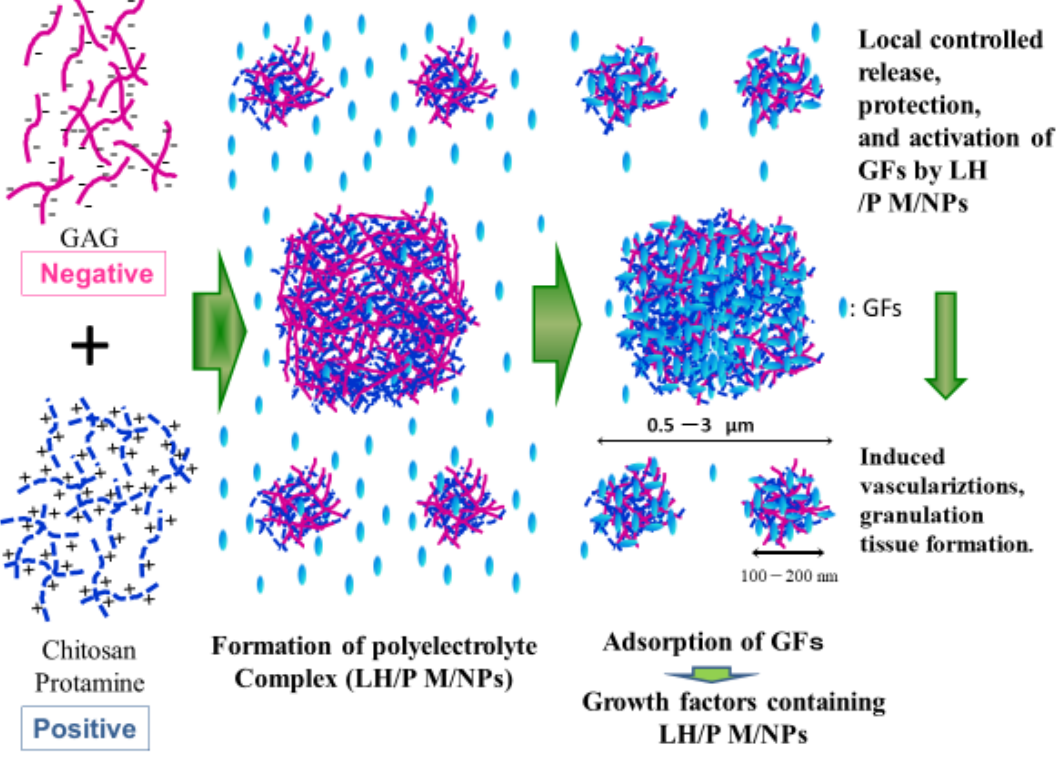
Figure 4. Production of growth factor (GF)-containing LH / P N / MPs as PECs. LH / P N / MPs are specifically bound to FGF-2, HGF, and other GFs secreted from platelets.